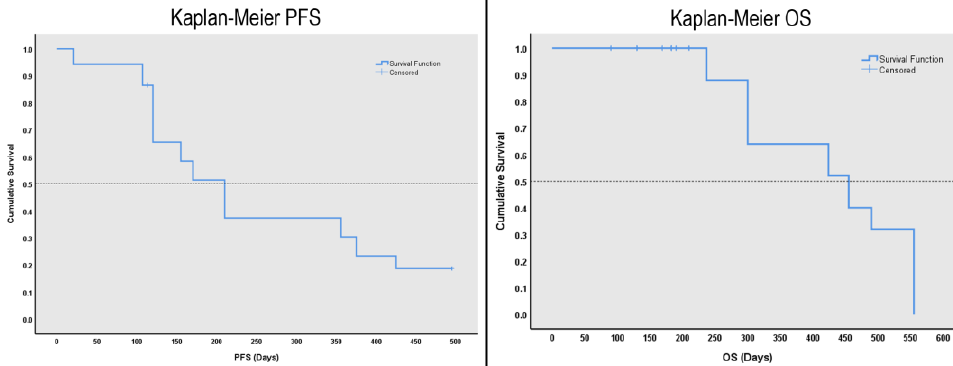
Figure 4. Survival analyses “Kaplan Meier” curves. Part ( left ) represents the curve for PFS. Part ( right ) represents the curve for OS.